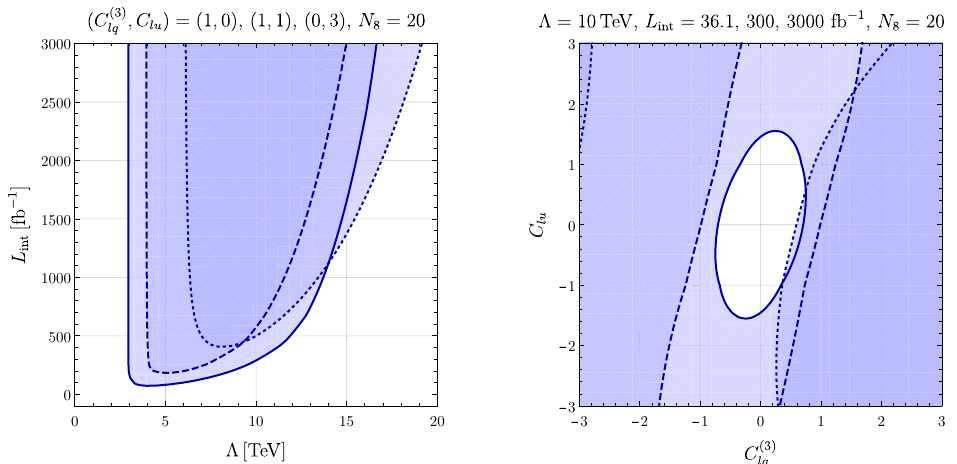
Figure 2 . Exclusion regions from proposed LHC searches. In the left panel, we show exclusion regions for fixed values of Wilson coefficients as functions of the scale Λ and the integrated luminosity , C lu ) = (1 , 0), (1 , 1) and L int . Solid, dashed and dotted lines correspond to the combinations ( C (3) lq (0 , 3), respectively. In the right panel, the scale Λ is fixed and the exclusion regions in the plane of the two Wilson coefficients is shown for L = 36 . 1 , 300 and 3000 fb − 1 int